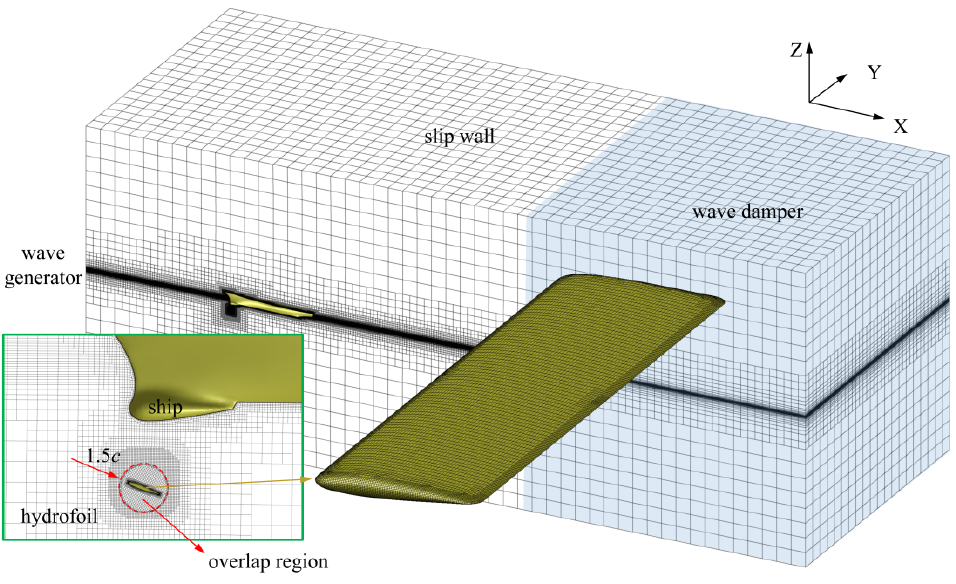
Figure 3. Schematic diagram of computational domain (one half of the calculation domain), boundary conditions, and local successive mesh refinement.